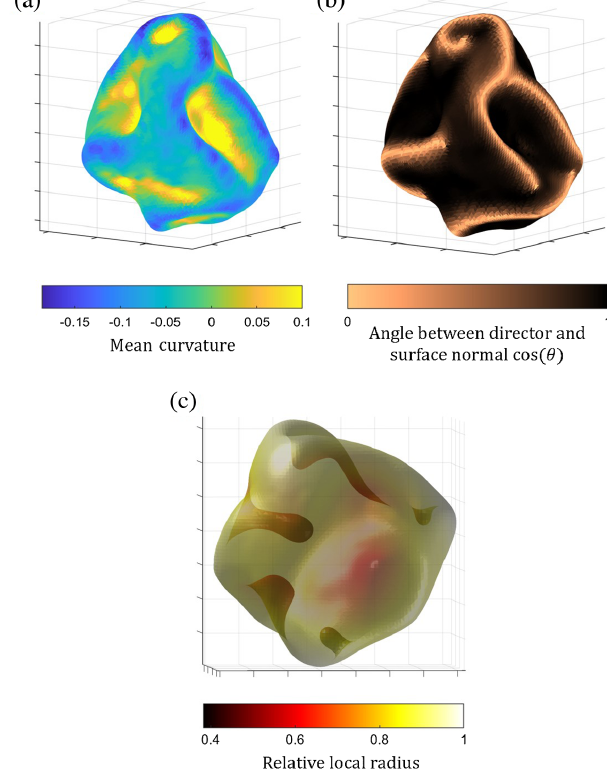
FIG. 14. Snapshots of a contractile drop showing (a) the mean curvature and (b) the orientation of the director field on the surface. Contractile droplets which contain disclination lines show stripes of in-plane director alignment on the surface which connect end points of the disclination lines in the bulk (Fig. 3).